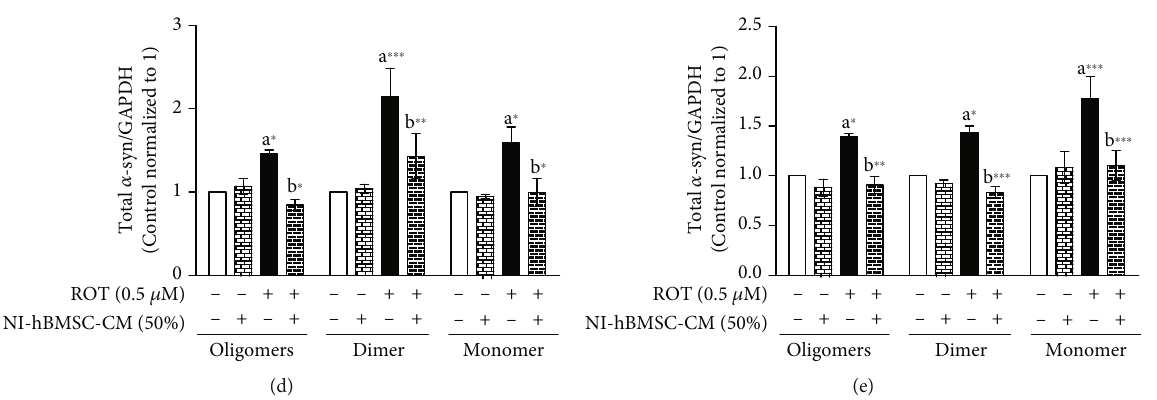
Figure 3: SH-SY5Y cells were seeded as 5 × 10 4 cells/mL of DMEM containing 1% FBS and used for experiments after overnight incubation. Cells incubated with the absence or presence of ROT (0.5 μ M) for 48h were treated with NI-hBMSC-CM (50%) during the last 24h. Cell lysates were prepared as 1% Triton X-100-soluble and Triton X-100-insoluble (2x SDS soluble) fractions. p-S129 and total α -syn were analyzed from 1% Triton X-100-insoluble (2x SDS soluble) fractions by Western blotting using 12% and 8% SDS-PAGE gels (a). Each picture is representative of three independent experiments. Bar graphs represent fold changes in p-S129 α -syn/GAPDH (b, d) and total α - syn/GAPDH (c, e) in SDS-PAGE gels of 12% (b, c) or 8% (d, e). Data are the mean ± SEM of three independent experiments and analyzed by one-way analysis of variance (ANOVA) followed by Tukey ’ s post hoc test. Statistical signi fi cance: a compared with control; b compared with ROT; ∗ p < 0 : 05 , ∗∗ p < 0 : 01 , and ∗∗∗ p < 0 : 001 ratio ( p < 0 : 001 ; Figure 5(c)) with increasing the Bcl-2/Bax